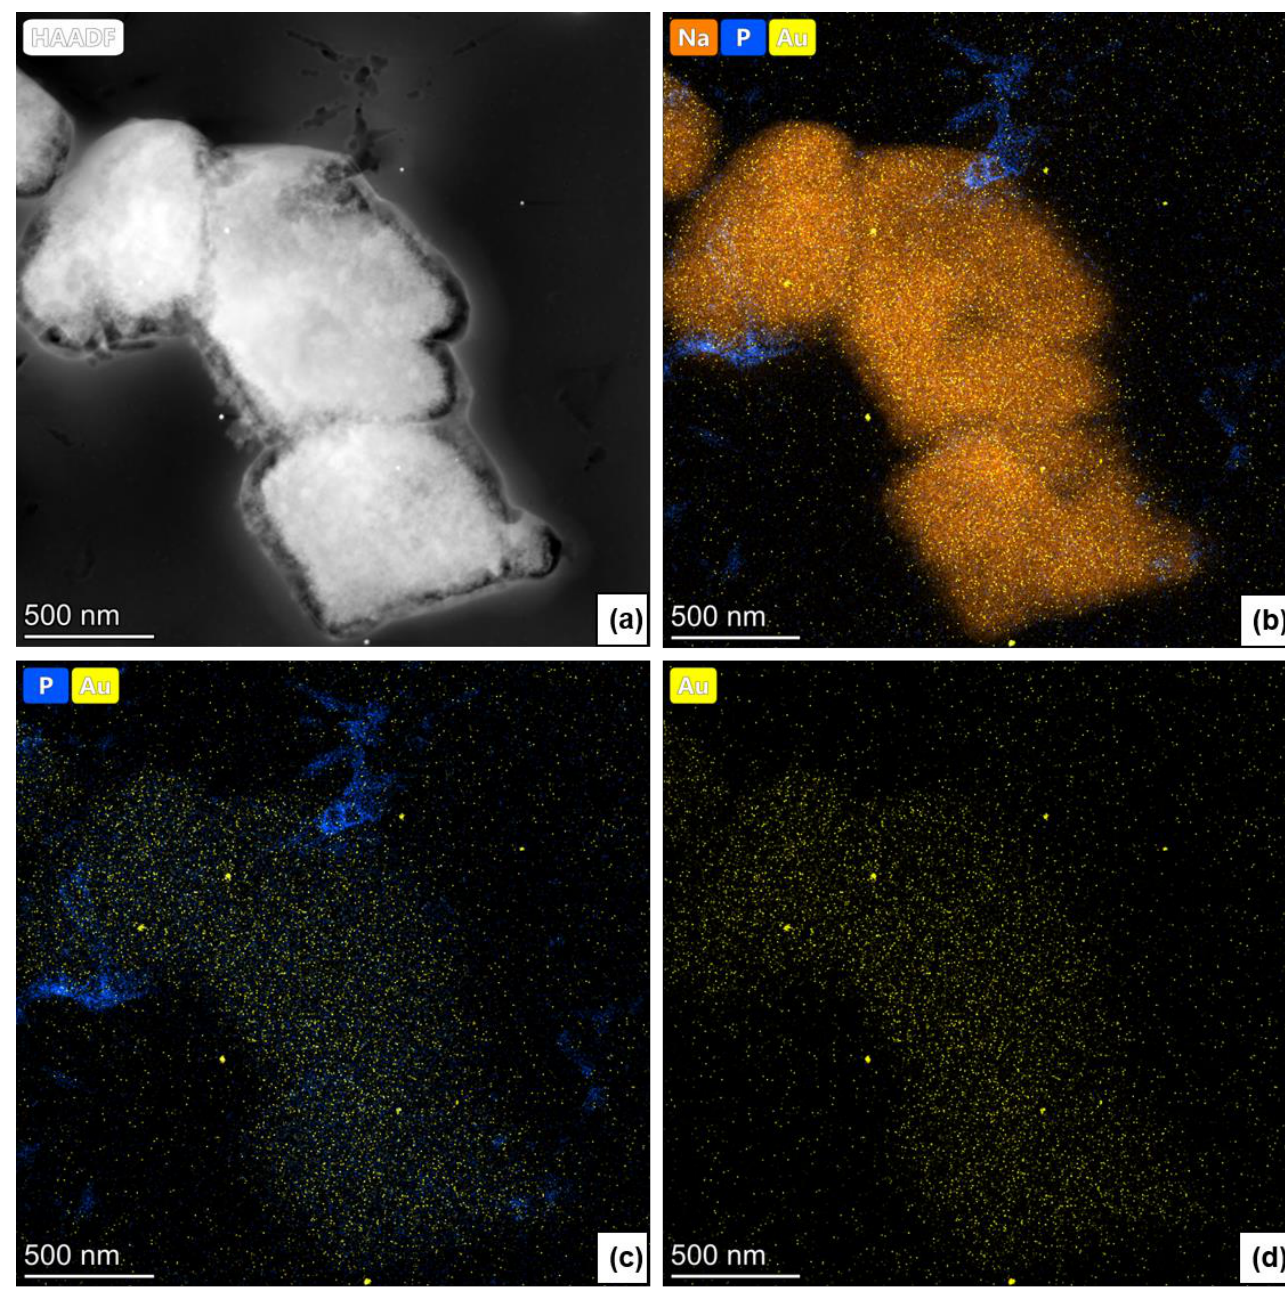
Figure 4. ( a ) STEM image of the HAP|PEI-Au-FUOL; ( b ) corresponding EDX map of the Na, P, Au distribution; ( c ) corresponding EDX map of the P, Au distribution; ( d ) corresponding EDX map of the Au distribution.